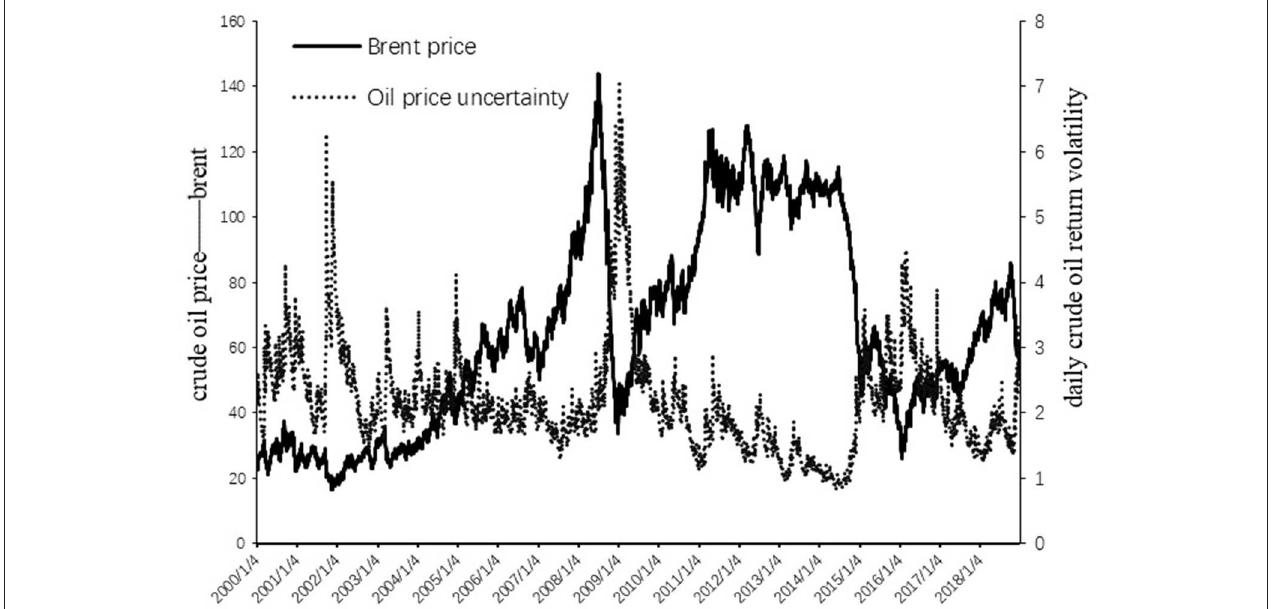
FIGURE 2 | The price and volatility of international crude